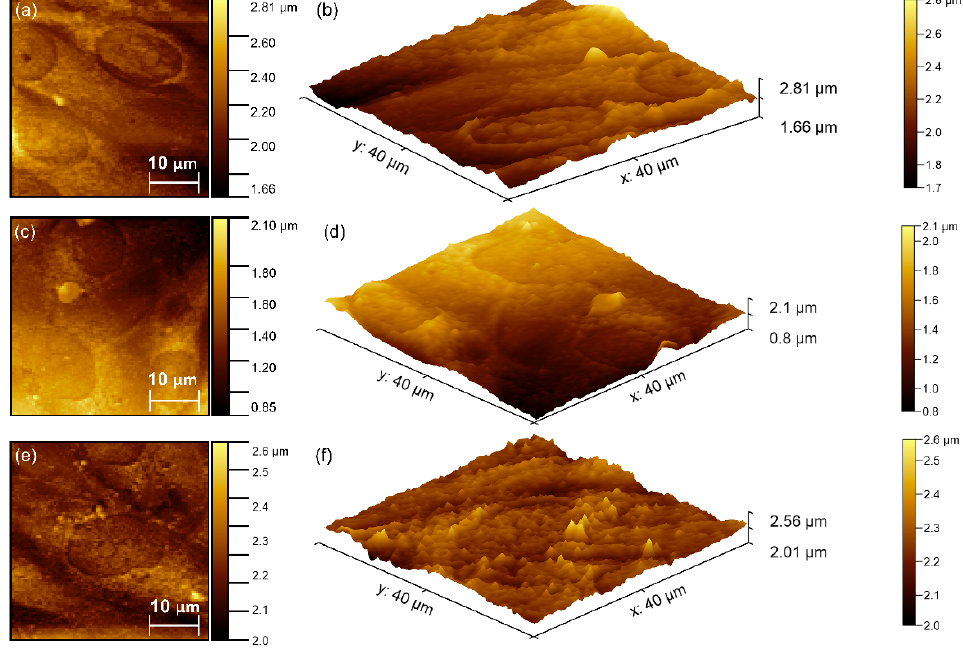
Figure 12. 2D AFM topography of MG63 (ATCC CRL1427) cells grown onto HAp ( a ), 0.05 AgHAp ( c ), 0.1 AgHAp ( e ) coatings and 3D representation of the 2D AFM topographies MG63 (ATCC CRL1427) cells grown onto HAp ( b ), 0.05 AgHAp ( d ), and 0.1 AgHAp ( f ) coatings.